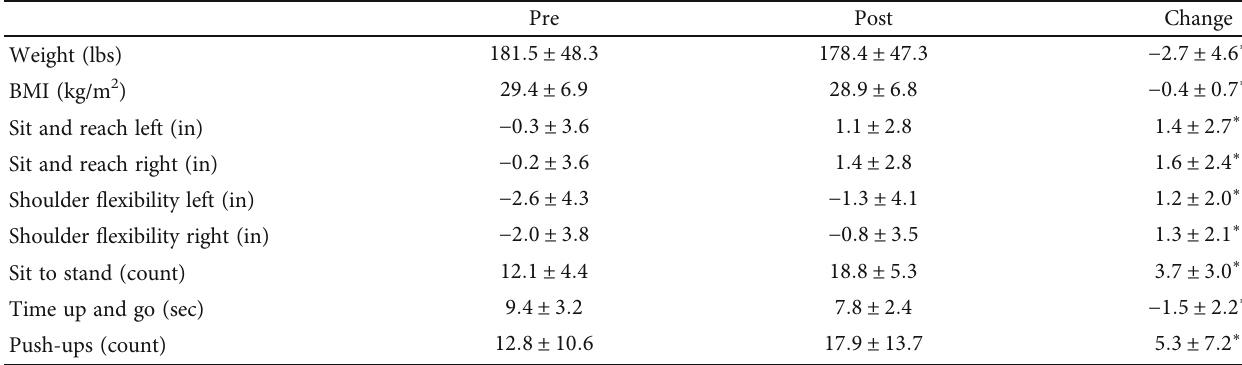
Table 4: Performance